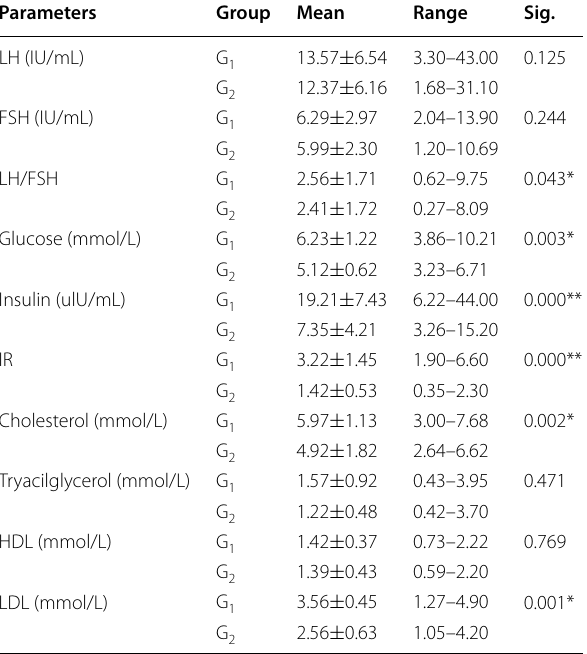
Table 2 Overview of serum biochemical parameters in patients with therapy (G ) and without therapy (de novo, G 2 presented as mean SD ±